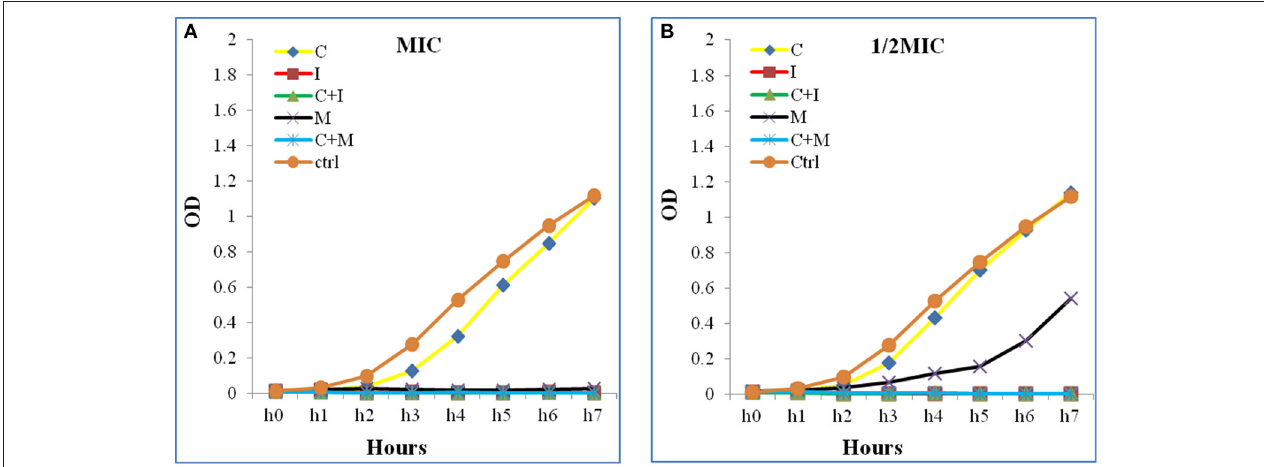
FIGURE 3 | Time kill curve assay chart showing the synergistic effect of a representative strain (A) at 1 × 1MIC and (B) at 0.5 × 0.5 MIC. A significant decrease in the bacterial growth in both combinations (C + M and C + I) when compared to Colistin alone at 1 × 1 MIC and 0.5 × 0.5 MIC were detected. The Optical density (OD) is represented as a function of time. C, colistin; I, imipenem; C + I, colistin-imipenem; M, meropenem; C + M, colistin-meropenem; Ctrl,